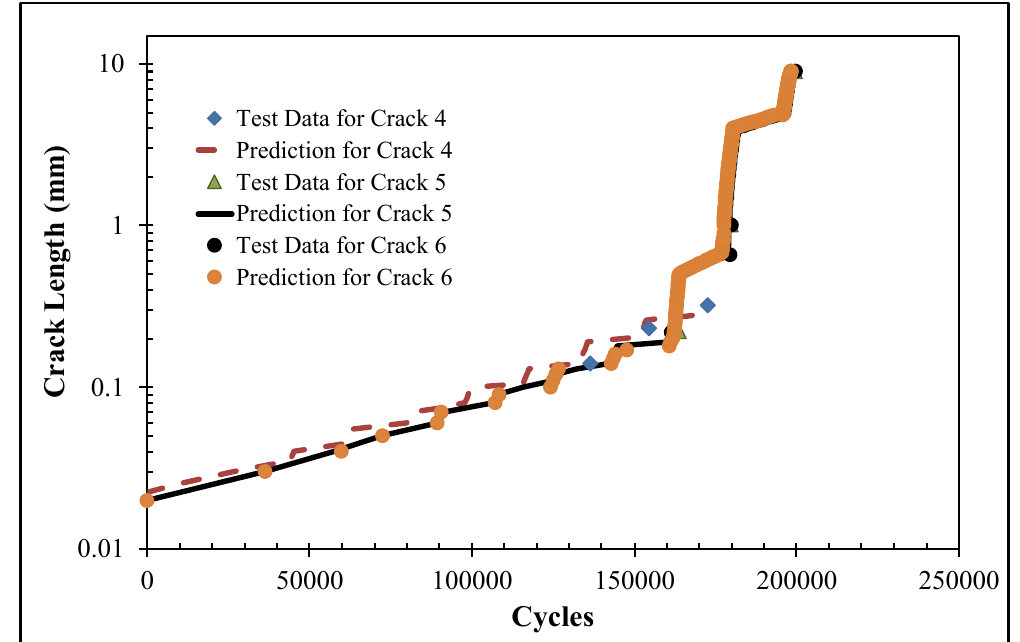
Figure 21. Measured and computed crack length histories for cracks 1–3 in specimen DNHS ‐ 1 ‐ 12.